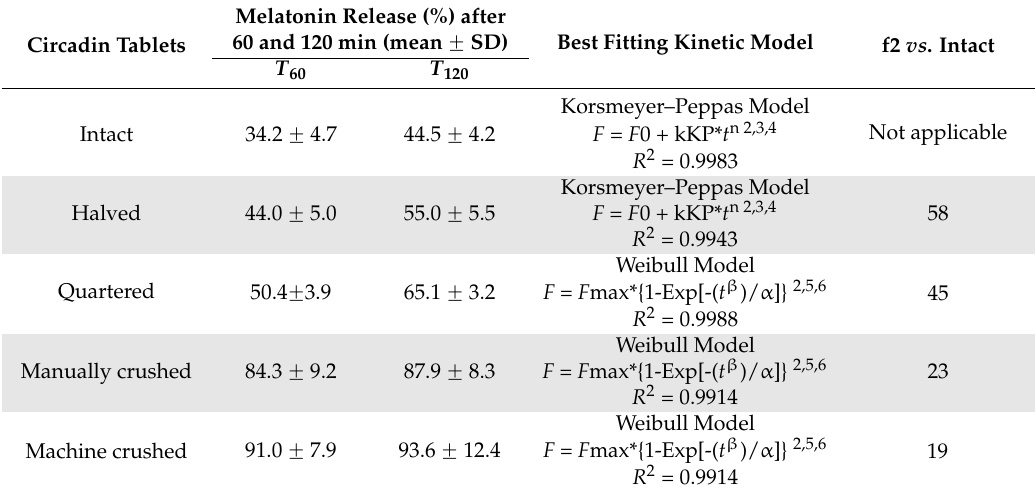
Figure 3. Comparison of dissolution profiles for release of melatonin from Circadin tablets in intact, halved, quartered, and crushed form (data represented mean ± SD, n = 6). Table 2. Kinetics of melatonin release from Circadin tablets, intact and after dividing or crushing the tablets ( n = 6).